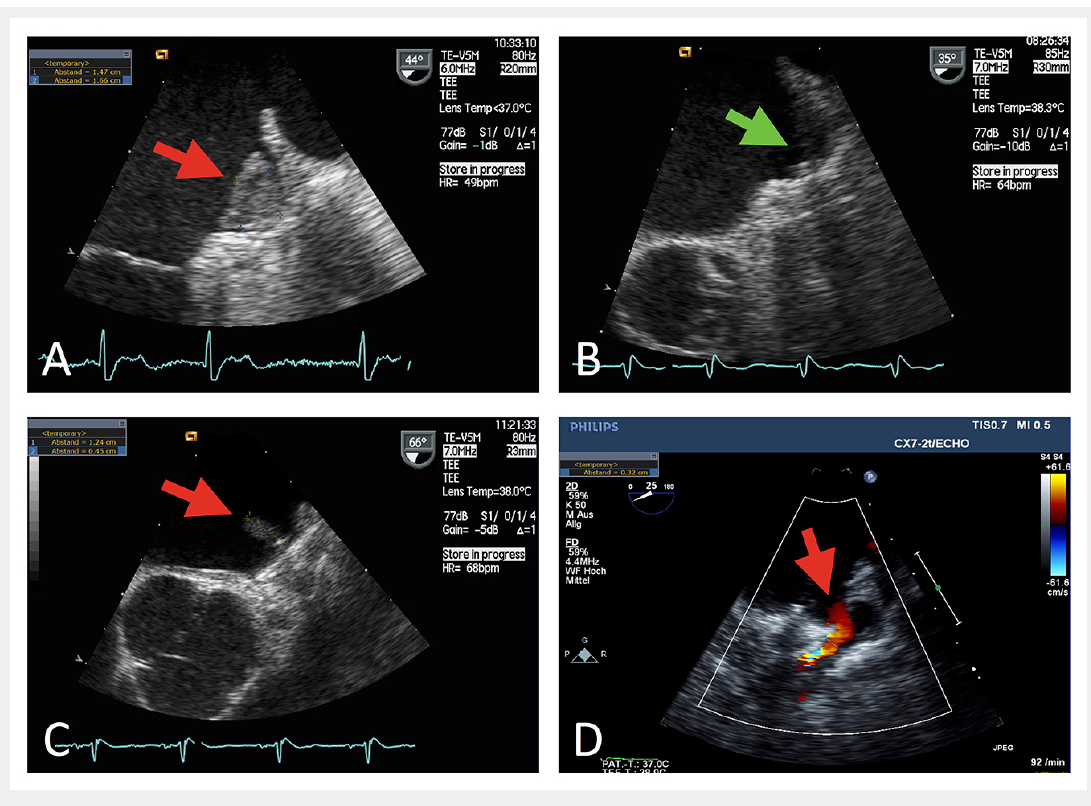
Figure 4 Examples of procedure-related adverse findings in the TOE follow-up 4 months after LAAC. The red arrow in panel A shows a device-adherent thrombus of 15 x 17 mm. After resumption of OAC, the thrombus had dissolved without clinical sequelae after 3 months (panel B, green arrow pointing on device surface). In panel C, the red arrow points towards a mobile thrombus of 12 x 5 mm which adheres to the central screw of the Amplatzer device. Also in this case, the thrombus could be dissolved by OAC without clinical consequences. The red arrow in panel D points at a residual shunt of 3 mm into the LAA due to suboptimal closure. LAA = left atrial appendage; LAAC = left atrial appendage closure; OAC = oral antocoagulation; TOE = transoesophageal